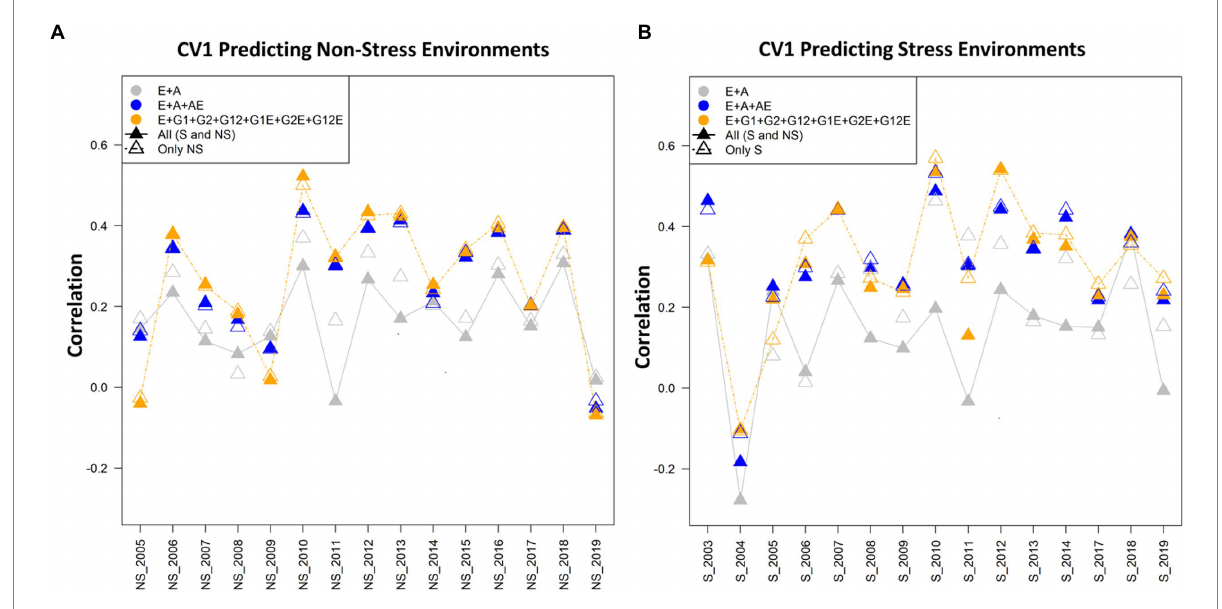
FIGURE 3 (A) The average correlation values obtained from predicting the grain yield for untested lines (CV1) for predicting non-stress conditions using the non-stress (NS) and combined [All (S and NS)] calibration sets. The plot depicts the correlations between the predicted and estimated values across the years 2005–2019, using model 1 (E + A), 2 and 5, respectively. (B) The average correlation values obtained from predicting the grain yield for untested lines (CV1) under the stress conditions using stress (S) and combined [All (S and NS)] datasets. The plot depicts the correlations between the predicted and estimated values across the years 2003–2019, using model 1 (E + A), 2 and 5,